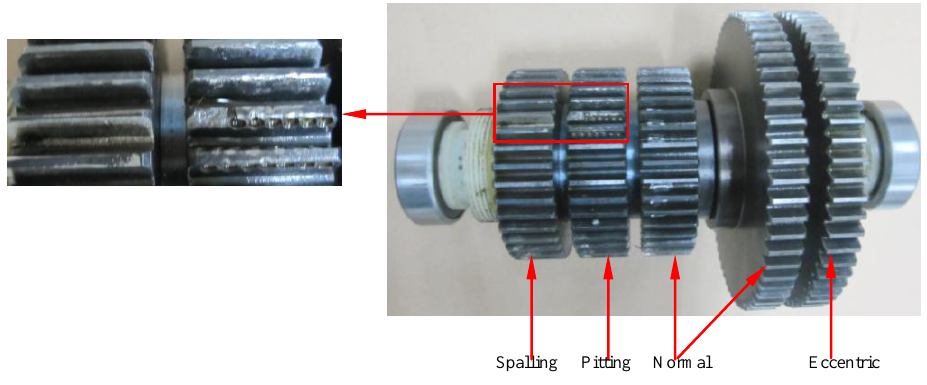
Figure 8. Gears defect in the shaft 2.